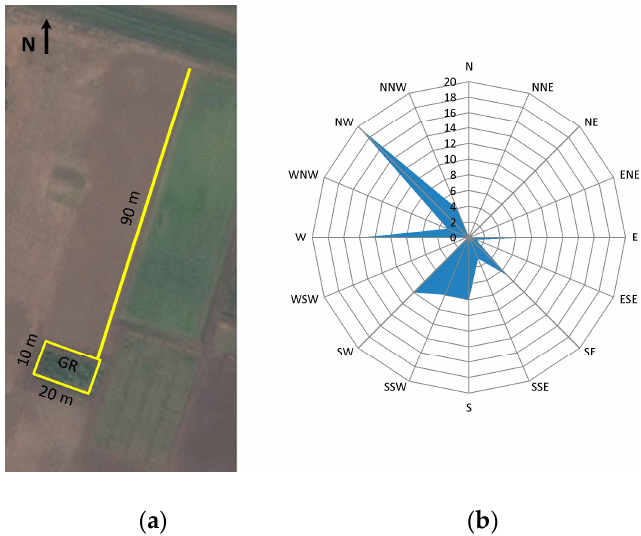
Figure 1. ( a ) Satellite image of the pollen-mediated gene flow experiment in Lolium perenne : parcel of glyphosate-resistant plants (GR) as source of pollen, and glyphosate susceptible plants (yellow segments) as pollen receptors; ( b ) Wind rose showing the frequency distribution (%) of wind directions at 2 m above ground level for November (average daily wind direction from 2008 to 2012) in Chacra Experimental Integrada Barrow.